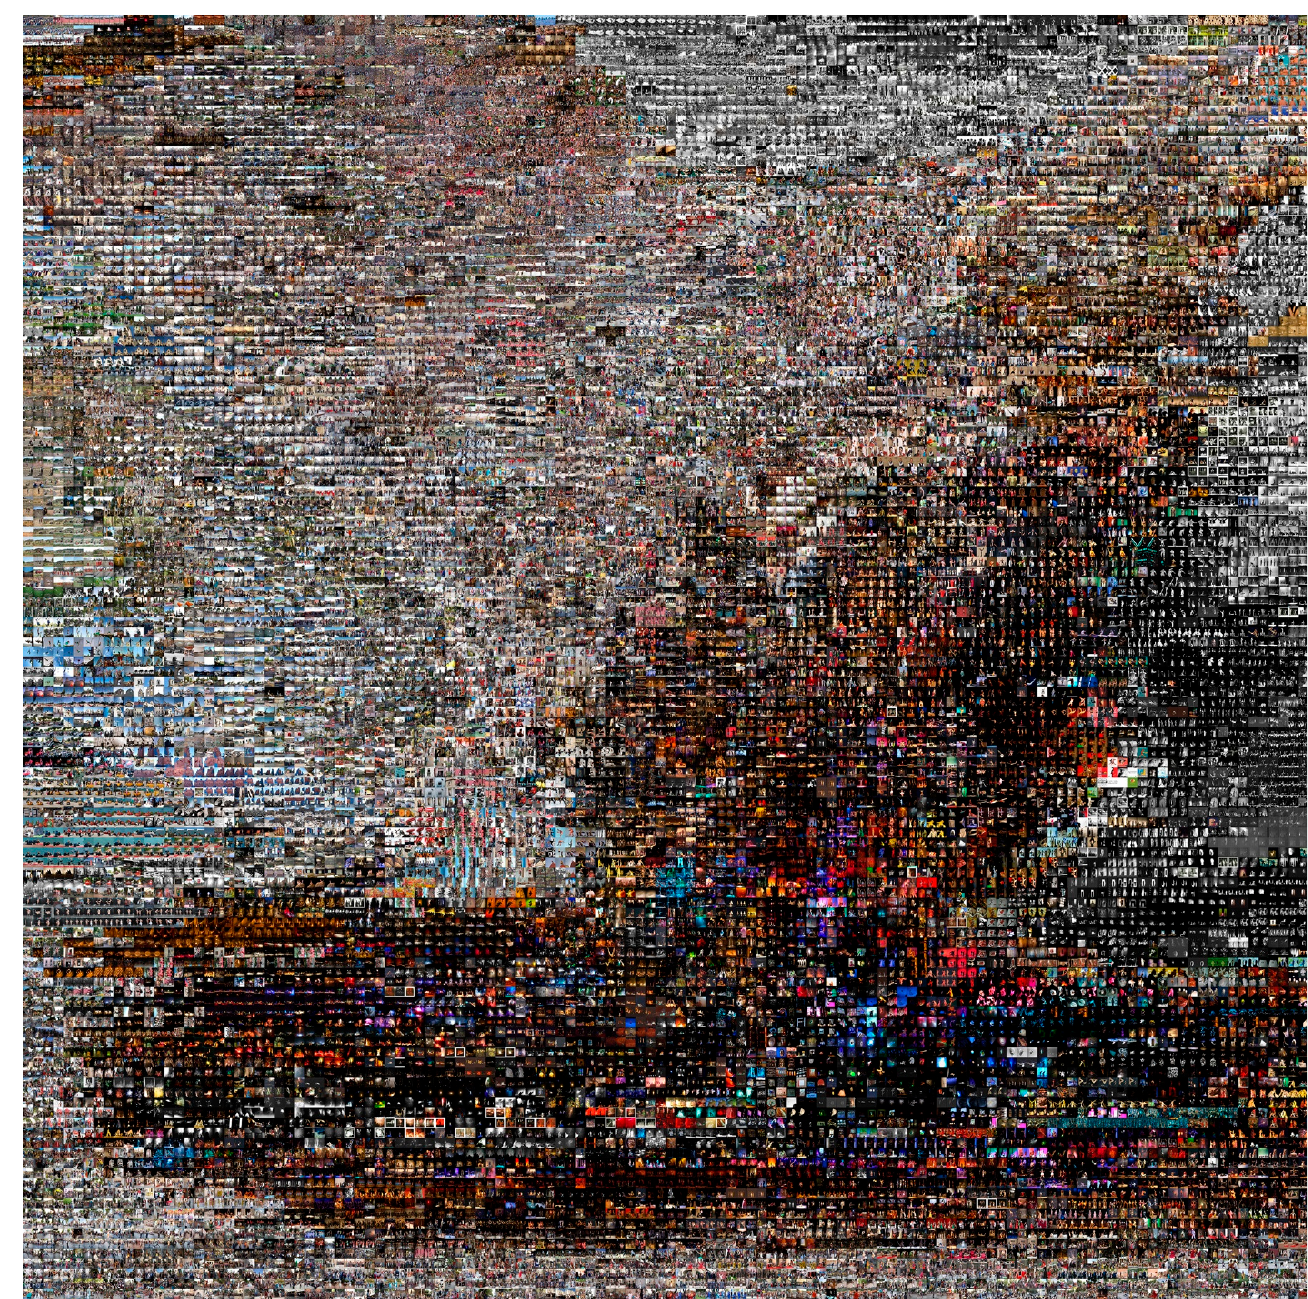
Figure 16. Digital image containing 10,000 photographs regarding popular culture, ordered using the ResNet-50 convolutional neural network (2 × 2 m). © Pilar Rosado.